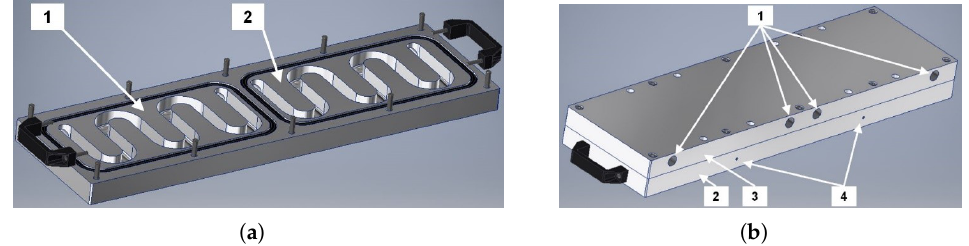
Figure 3. Design of two-section MTEG hot side heat exchanger; ( a ) view of the fluid circulation channels, 1—section I, 2—section II; ( b ) assembly view of the exchanger model, 1—channel exit location, 2—intermediate plate, 3—plate with channels, 4—temperature measurement points on the cover